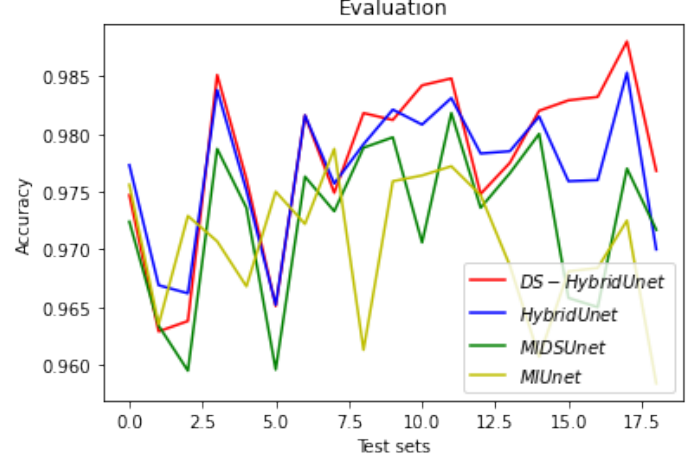
Figure 27. Comparison of Evaluation Accuracy.